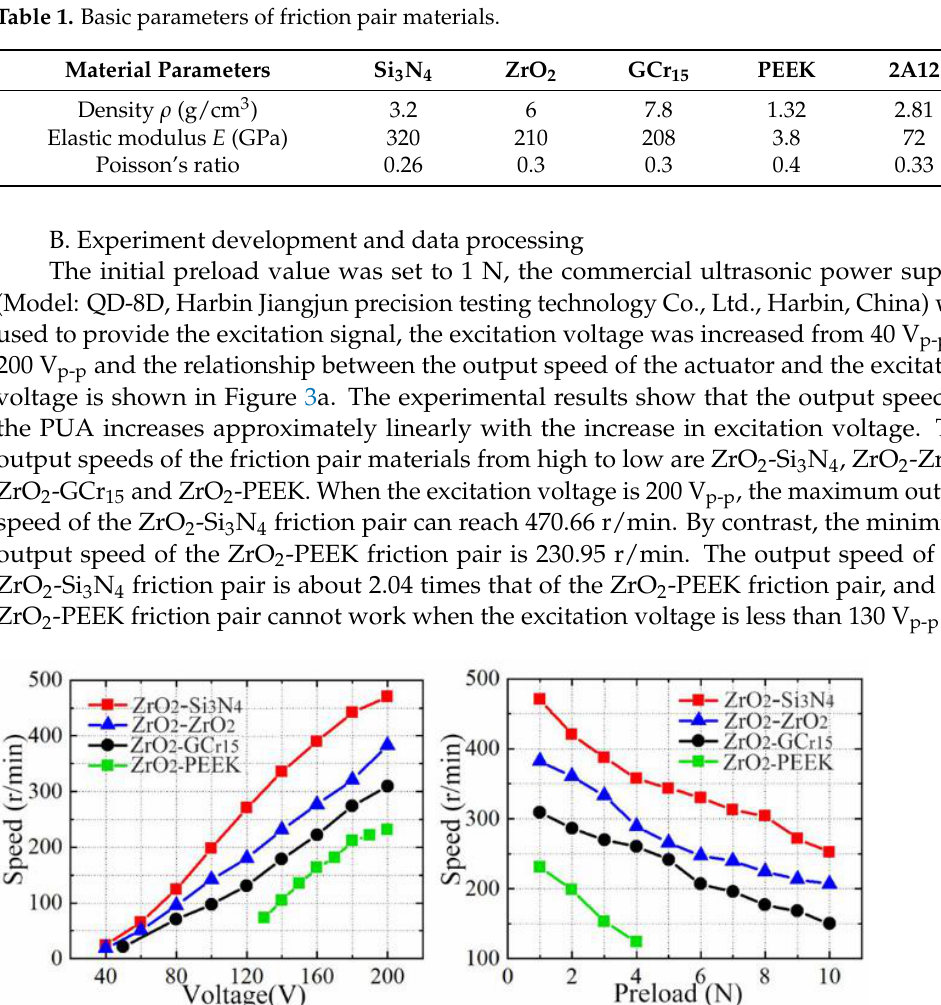
( b ) Relationship between the output and preload characteristics of the PUA.